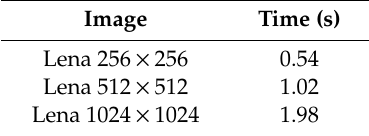
Table 4. The Encryption Time E ffi ciency Analysis